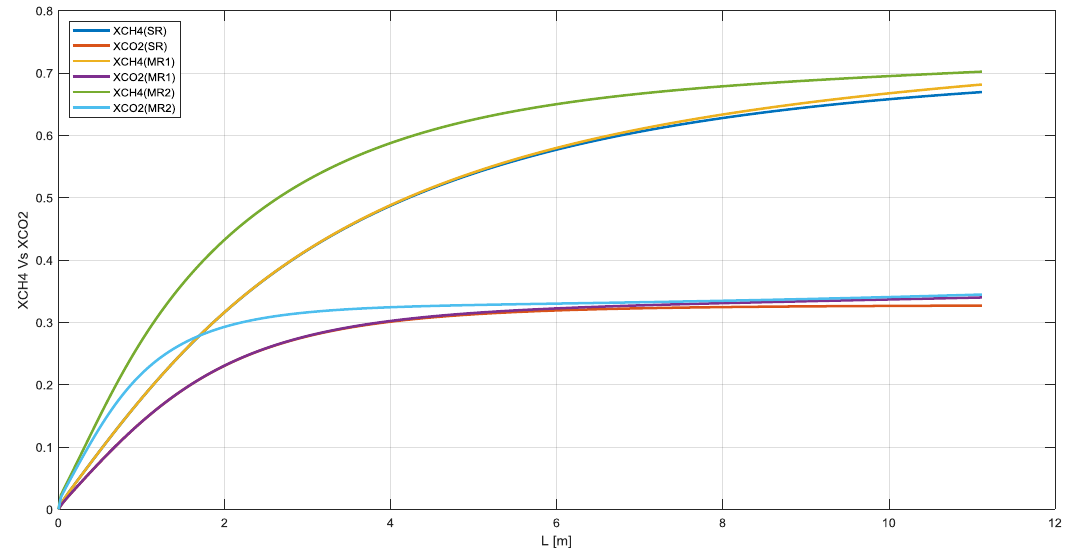
Figure 3. Methane conversion and carbon dioxide yield in SR, MR1, and MR2.